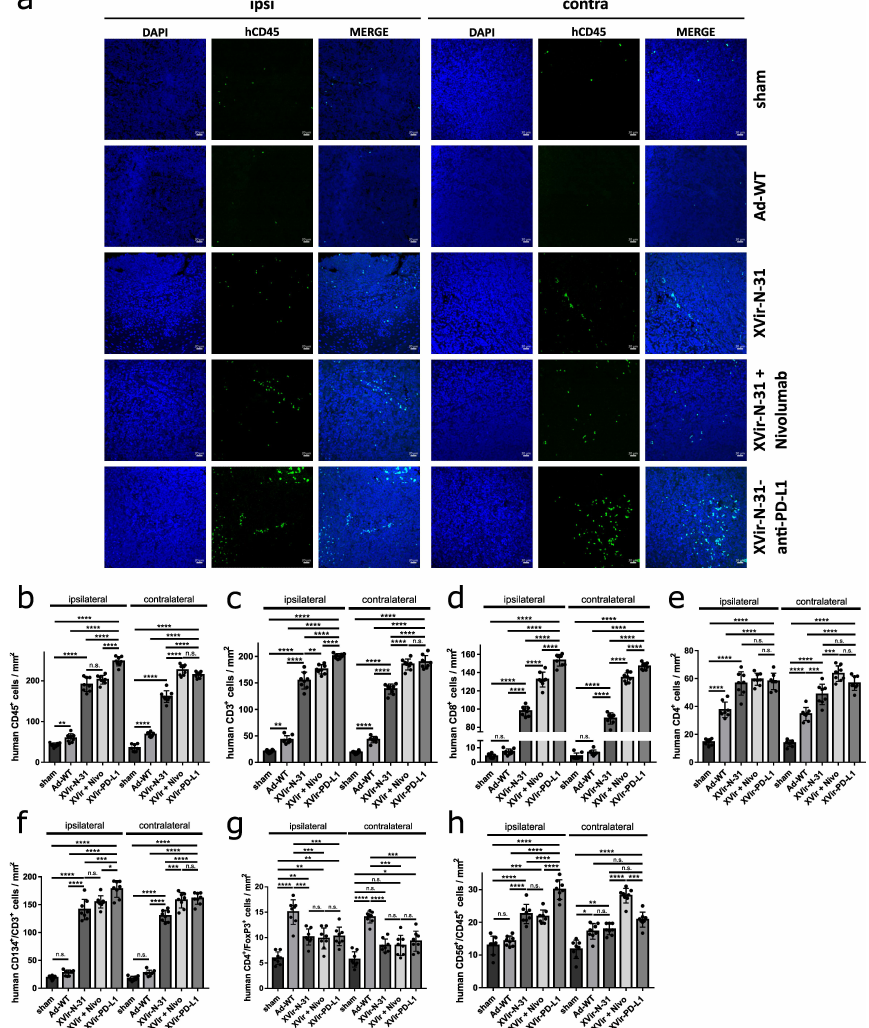
Figure 6. Intratumoral immune cell invasion after OVT. ( a ) Representative immunofluorescence pictures of human immune cell infiltration into the U87MG tumors in NSG mice (n = 8 mice per group, five sections per tumor, per side). Brain sections were stained with DAPI (blue) and anti-human CD45 (green). Pictures were taken 35 days after the injection of the sham virus into the tumor on the ipsilateral (injected) as well as on the contralateral (not injected) side. ( b – h ) Quantification of the infiltration of different immune cells per mm 2 in the GBMs located in the ipsilateral or contralateral hemisphere (( b ) human CD45 + cells; ( c ) human CD3 + T cells; ( d ) human CD8 + cytotoxic T cells; ( e ) human CD4 + T helper cells; ( f ) human CD3 + T cells expressing the activation marker CD134; ( g ) human CD4 + /FoxP3 + regulatory T cells; ( h ) human CD68 + /CD45 + NK cells). (XVir-PD-L1: XVir-N-31-anti-PD-L1; n = 7–8 tumors and five slices per were analyzed; SEM; n.s.: not significant; * p < 0.05; ** p < 0.01, *** p < 0.001, **** p < 0.0001). Unsurprisingly, PD-L1 has to be expressed on GBM cells to evoke a stimulatory effect by blocking the PD-1/PD-L1 interaction since in mice harboring PD-L1 negative LN-229 tumors, no additional stimulatory effect with regard to the amount of TILs was observed by XVir-N-31-anti-PD-L1 (Supplementary Figure